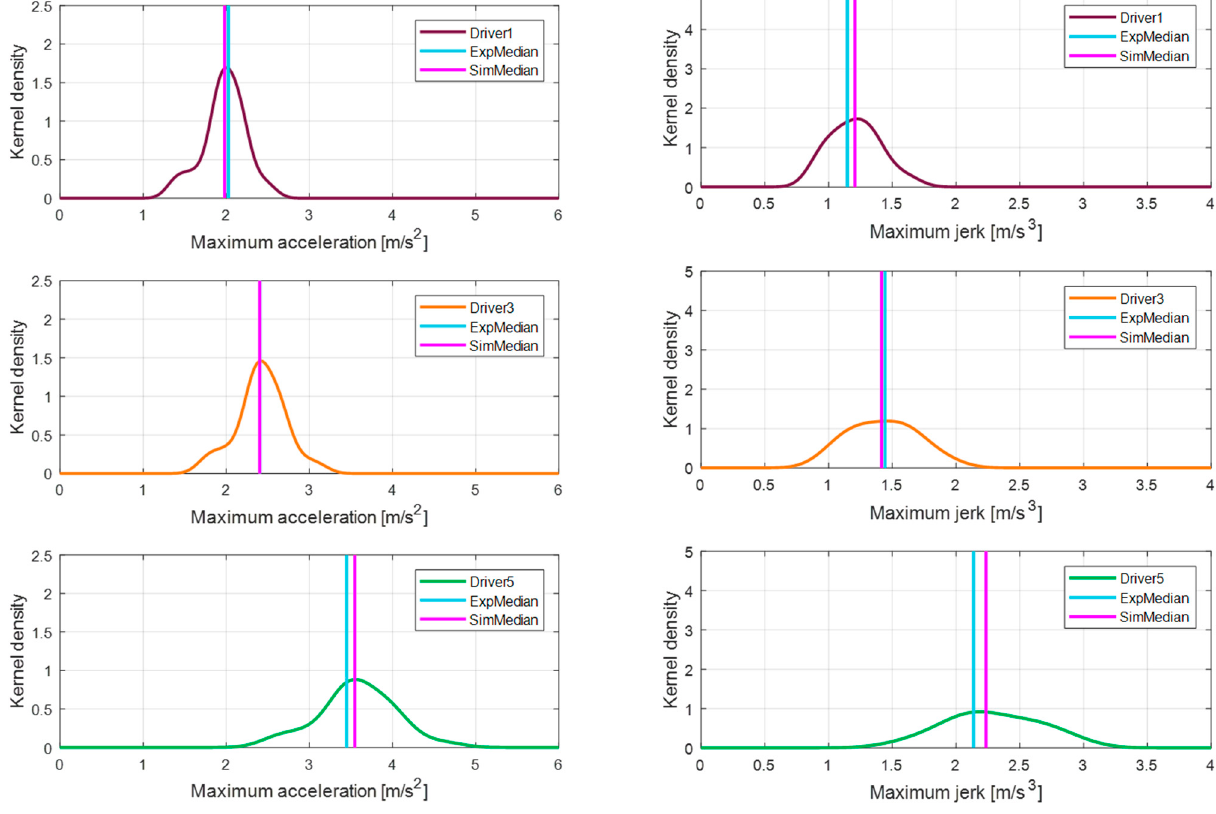
Figure 16. Comparison of the MaxAcc and MaxJerk distributions between the experiments and simulations. Table 5. Evaluation of the feature similarities between the experiments and simulations.